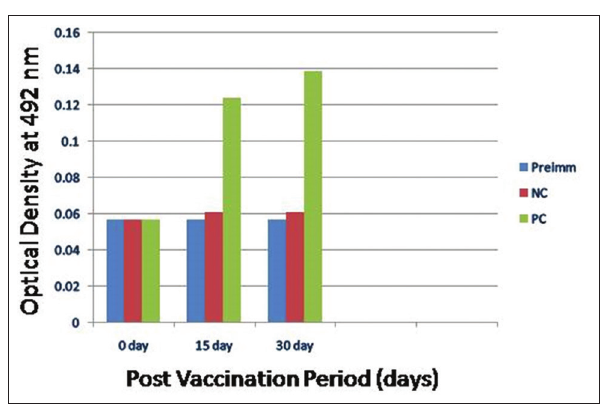
Mean absorbance values of the humoral immune response in rabbits evaluated at different time interval at dilution 1:25600. Preimm: Pre immunized serum, NC: Negative control, PC: Positive